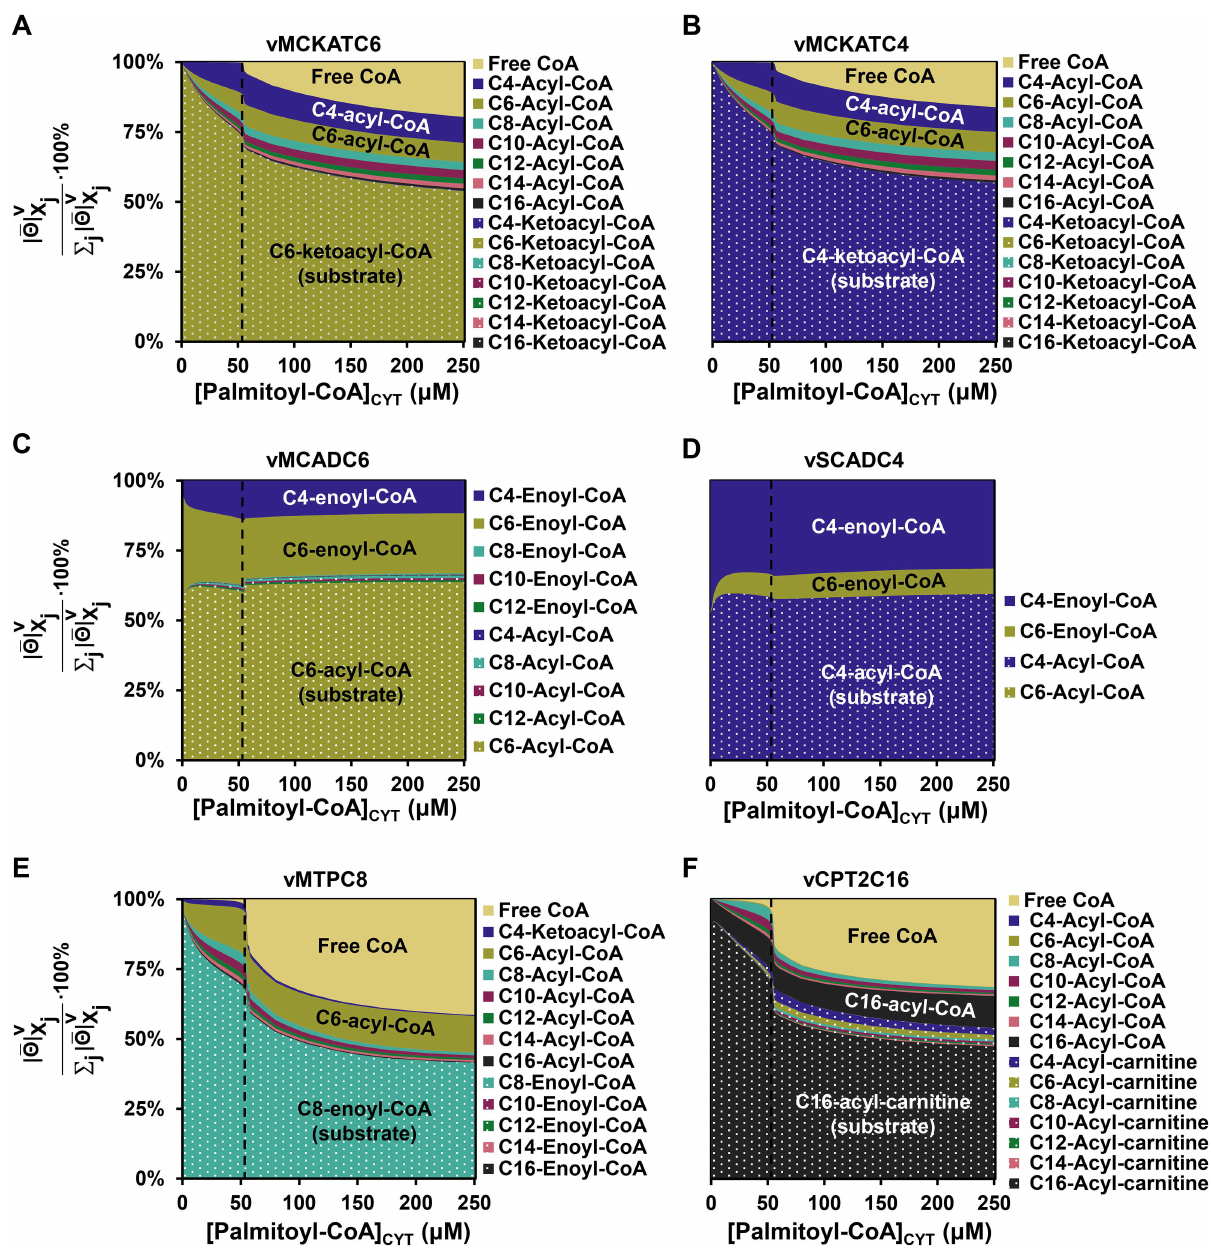
j Θ j v Xj P (cid:1) 100 % , of j j Θ j v Xj